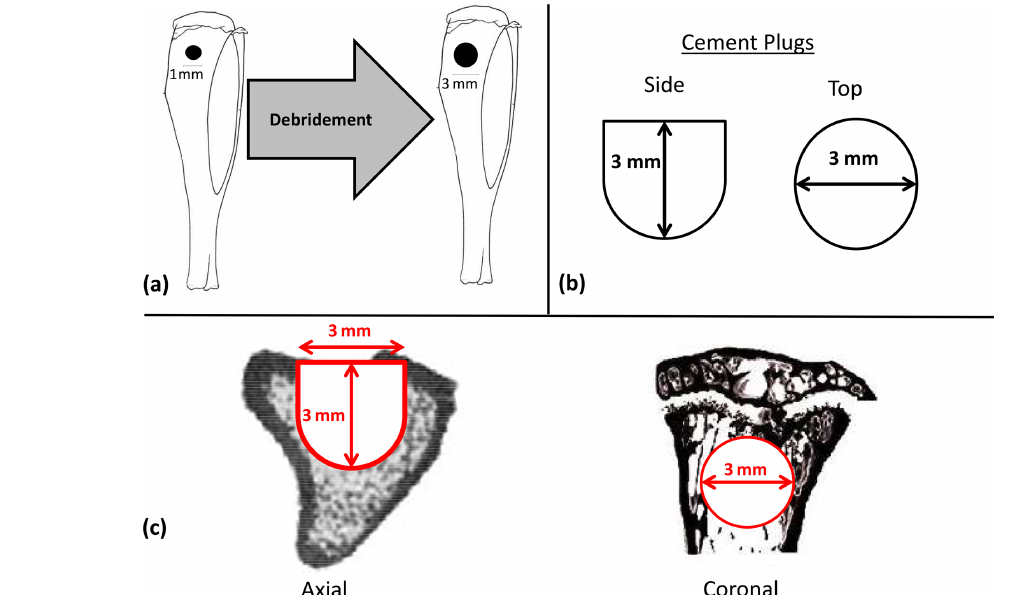
Figure 2. Diagrams of experimental materials and regions of interest. After confirmation of osteomyelitis, all animals underwent debridement using a 3mm diameter drill centered on the previous 1mm diameter hole used to create the osteomyelitic cavity with a depth stop of 3mm (a) . Afterwards animals randomized to receive CBVF or CG were filled with their respective plugs (b) . During microCT testing, the region of interest (ROI) mimicked the contours of the original implant in its dimensions, which were 3mm in diameter to a depth of 1.8mm, at which point the remaining 1.2mm of depth was tapered to a diameter of 1.5mm (c)